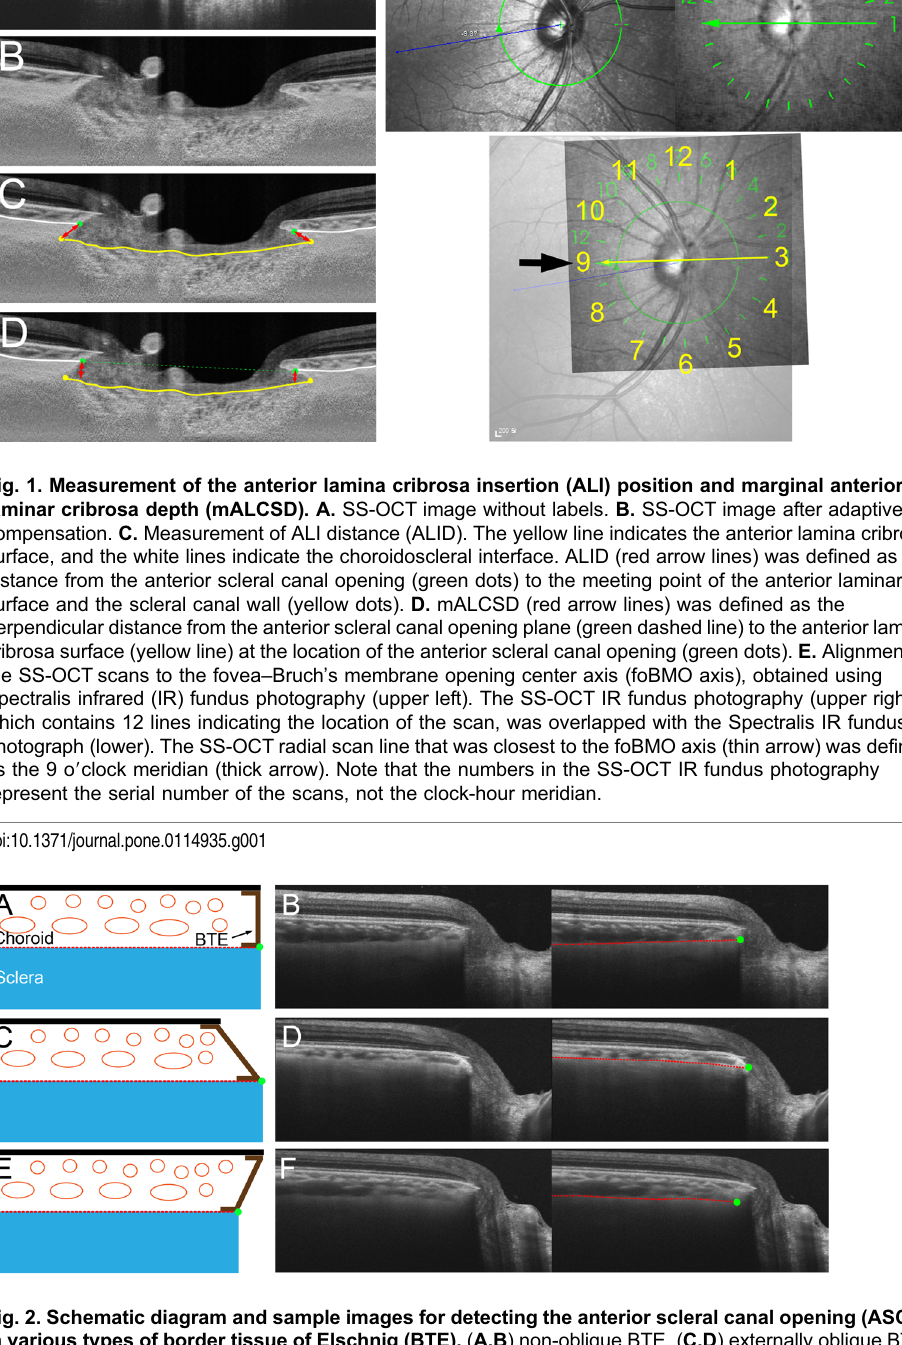
Fig. 2. Schematic diagram and sample images for detecting the anterior scleral canal opening (ASCO) in various types of border tissue of Elschnig (BTE). ( A,B ) non-oblique BTE, ( C,D ) externally oblique BTE, ( E,F ) internally oblique BTE. B, D, F. Left column is SS-OCT image without label, and right column is SS-OCT image with label. Anterior scleral surface (red dashed lines) is followed to the optic nerve head, and projected to define the ASCO (green